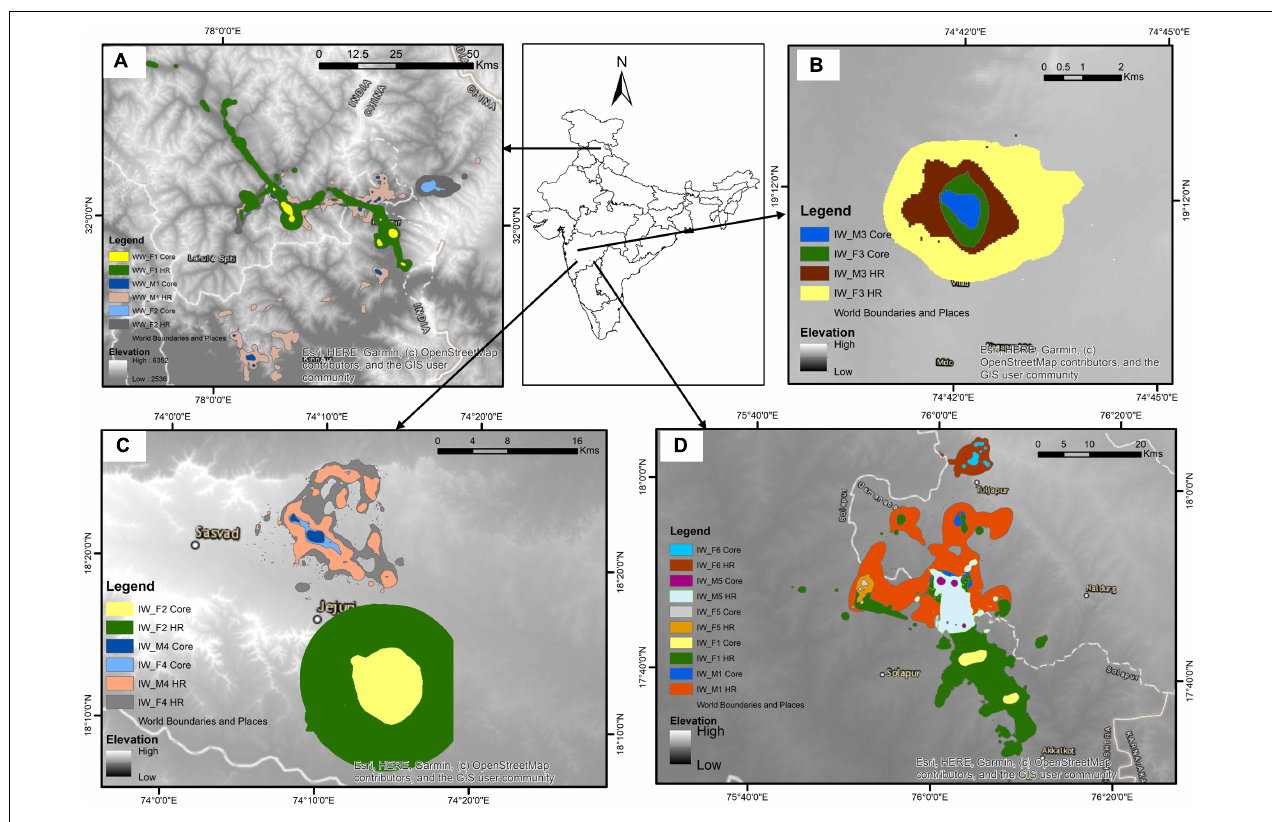
FIGURE 2 | Distribution pattern of the collared individuals [ (A) Woolly wolf, (B–D) Indian Wolf] using BBMM (50% contour- core area; 95% contour- home range) from Himachal Pradesh, and Maharashtra, India, respectively (BBMM: Brownian bridge movement model).